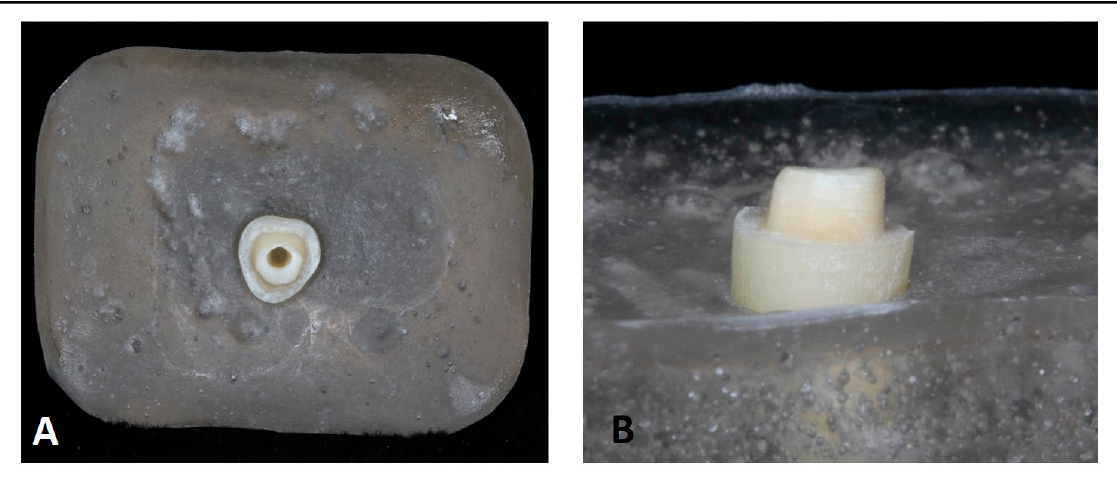
Figure 2. Preparation of tooth to have a 2 mm ferrule and a 1 mm shoulder finish line. ( A ) Occlusal view. ( B ) Lateral view.